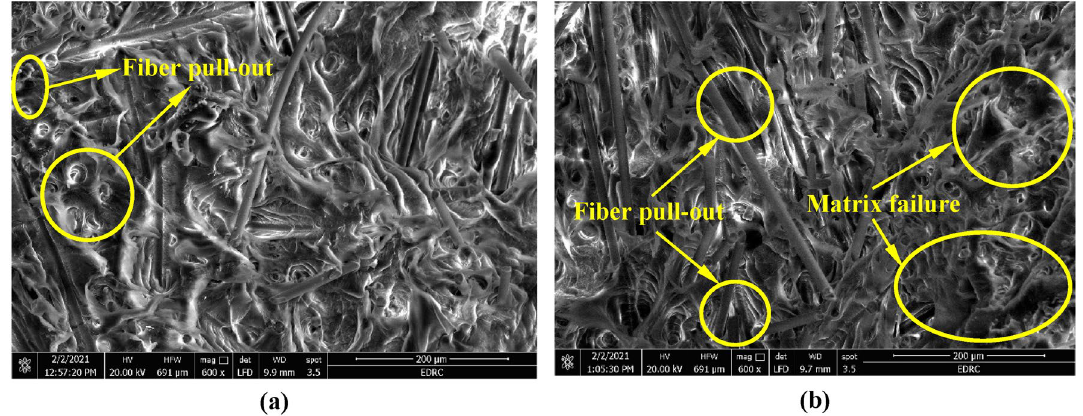
Figure 10. SEM images of a cross-section of the fractured zone of specimens; ( a ) 10 wt% GF (12 mm initial length) + 90 wt% PP and ( b ) 30 wt% GF (12 mm initial length) + 70 wt%